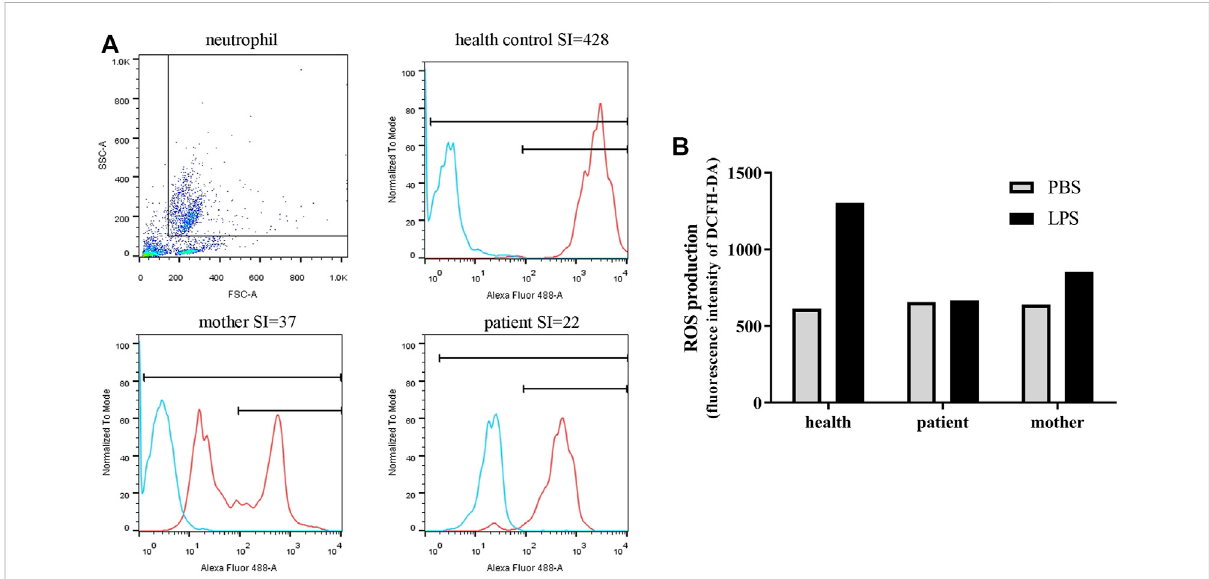
FIGURE 1 Neutrophil function and ROS production of the patient and his mother. (A) The SI values (neutrophil function) measured by DHR analysis with fl ow cytometry. Blue curve, stimulated with PBS; red curve, stimulated with PMA. (B) ROS production in PBMCs as measured by DCFH-DA. After stimulation, ROS production wasobviously enhancedinhealthyPBMCs,whereasno difference in fl uorescenceintensity wasobserved inthepatient